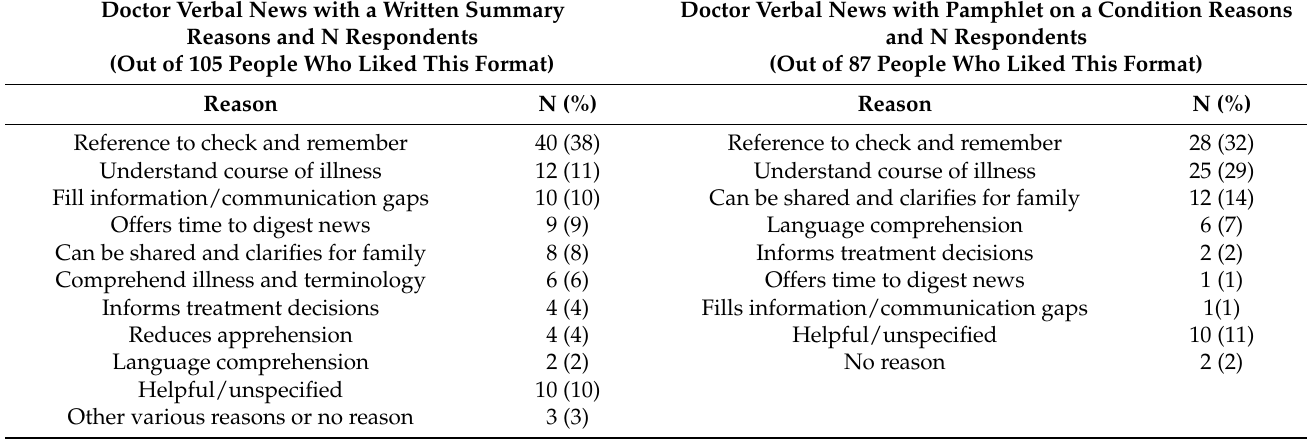
Table 4. Reasons for liking the top preferences of communication formats for prognostic